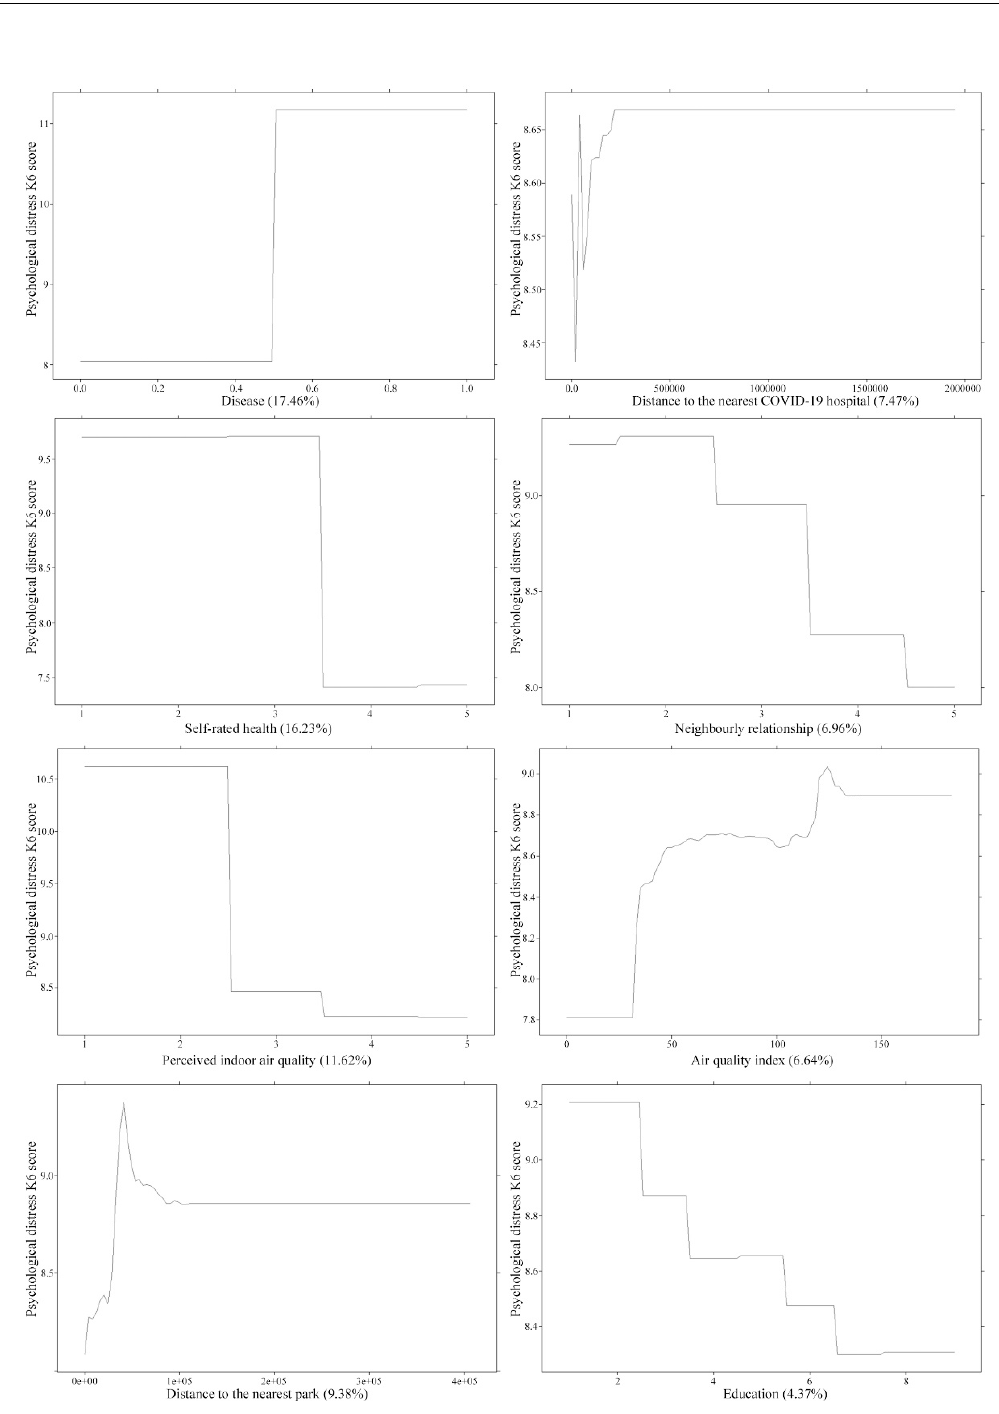
Figure 1. Association between predictors and psychological distress K6 scores.